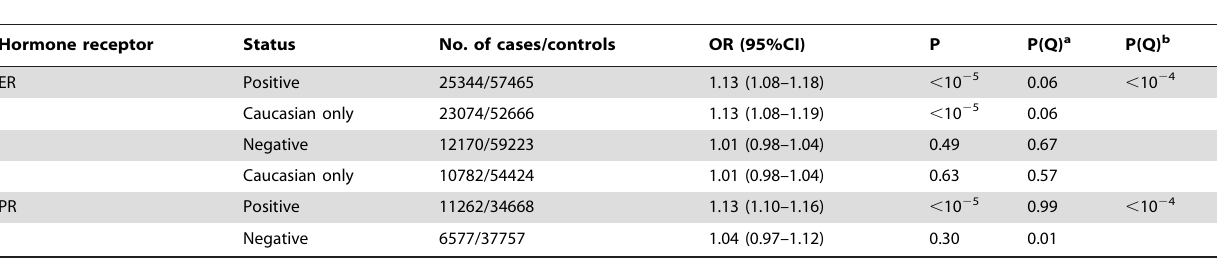
Table 3. Per-allele OR for 1p11-rs11249433 variant and BC risk stratified by hormone receptor status.